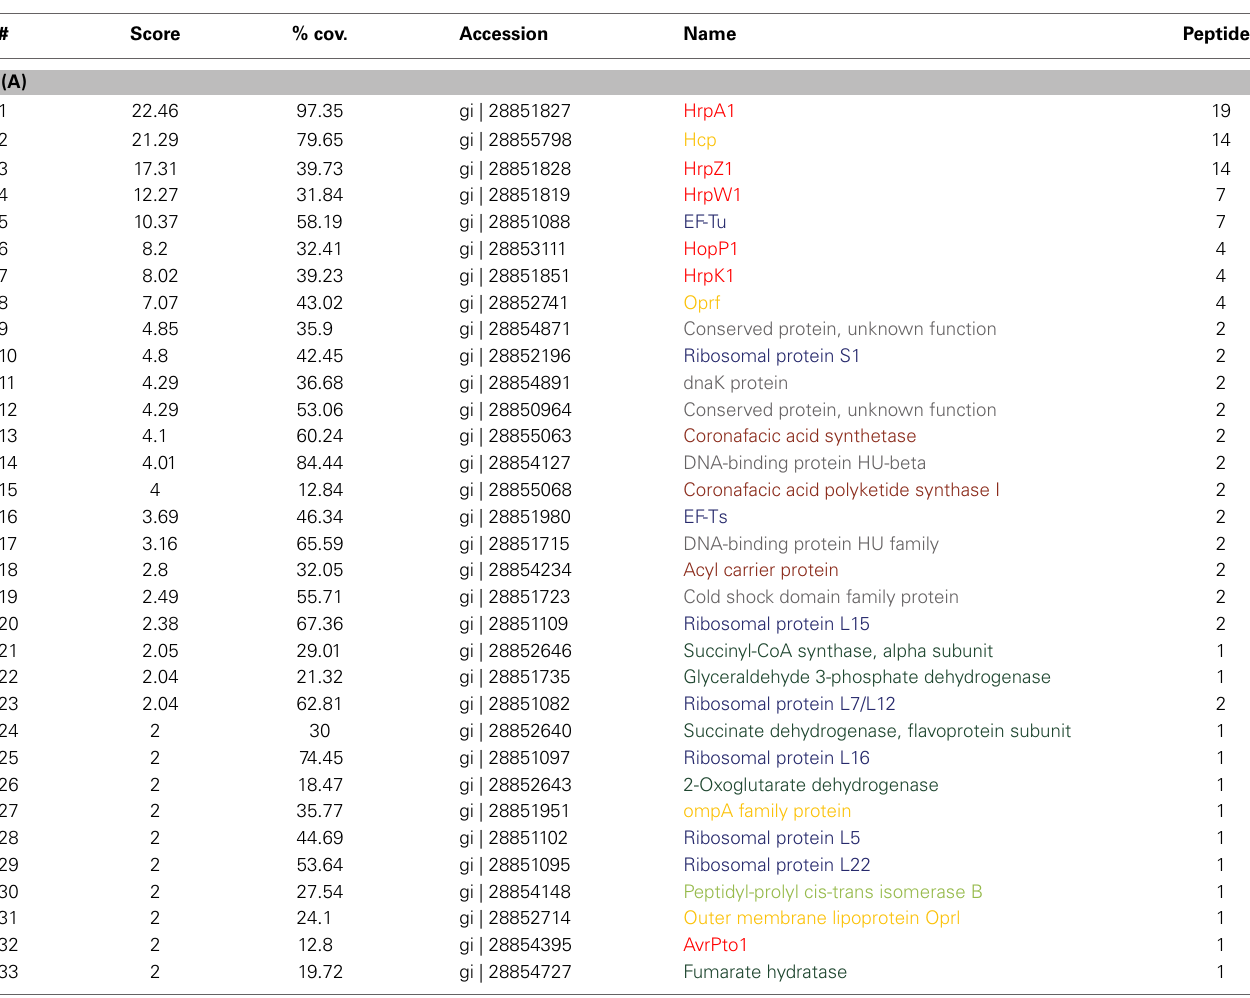
( Table 1A ). Hcp2, the hemolysin-coregulated protein, is assumed to be an extracellular component of the Type VI secretion system (T6SS) (Sarris et al., 2010). The cellular fraction shows fewer T3SS Table 1 | Abundant proteins identified in the extracellular fraction (A) and cell fractions